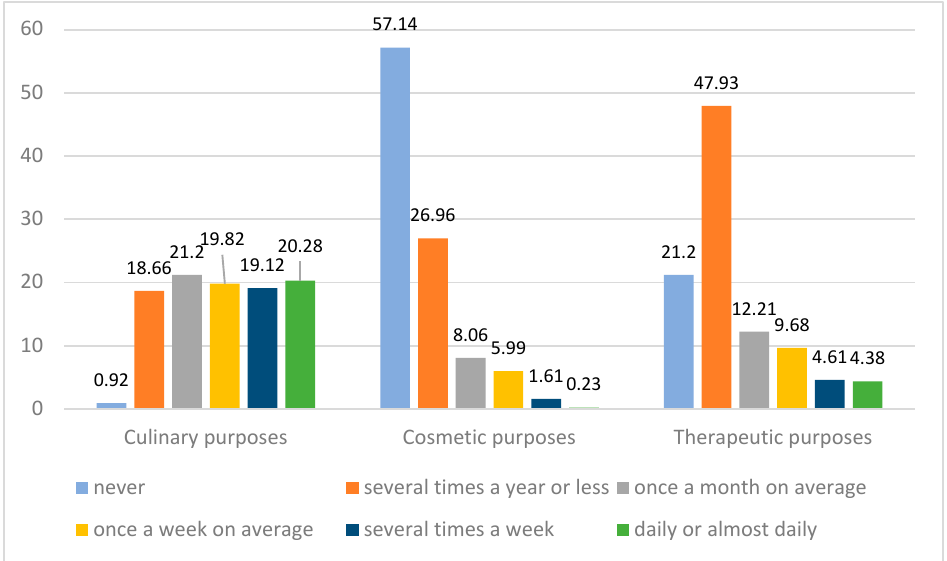
Figure 1. Frequency of honey usage for culinary, cosmetic, and medical purposes (n = 487, data in %). none being used for culinary purposes. For cosmetic purposes, beeswax (15.7%) and